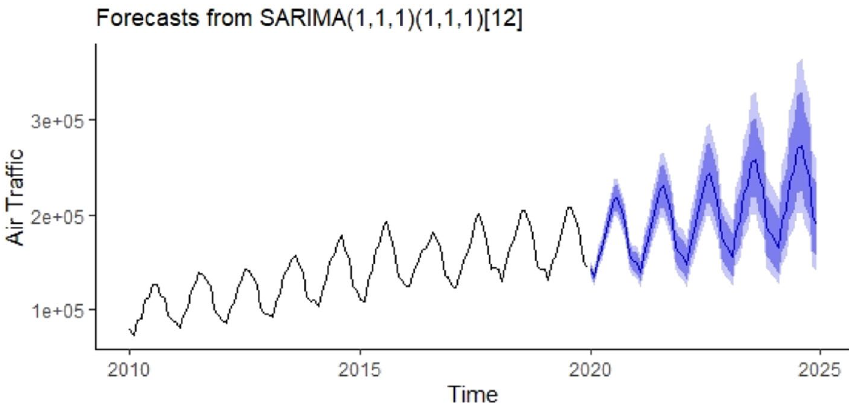
Figure 5. Forecasts for the years 2020–2024 with the help of the SARIMA(1,1,1)(1,1,1) 12